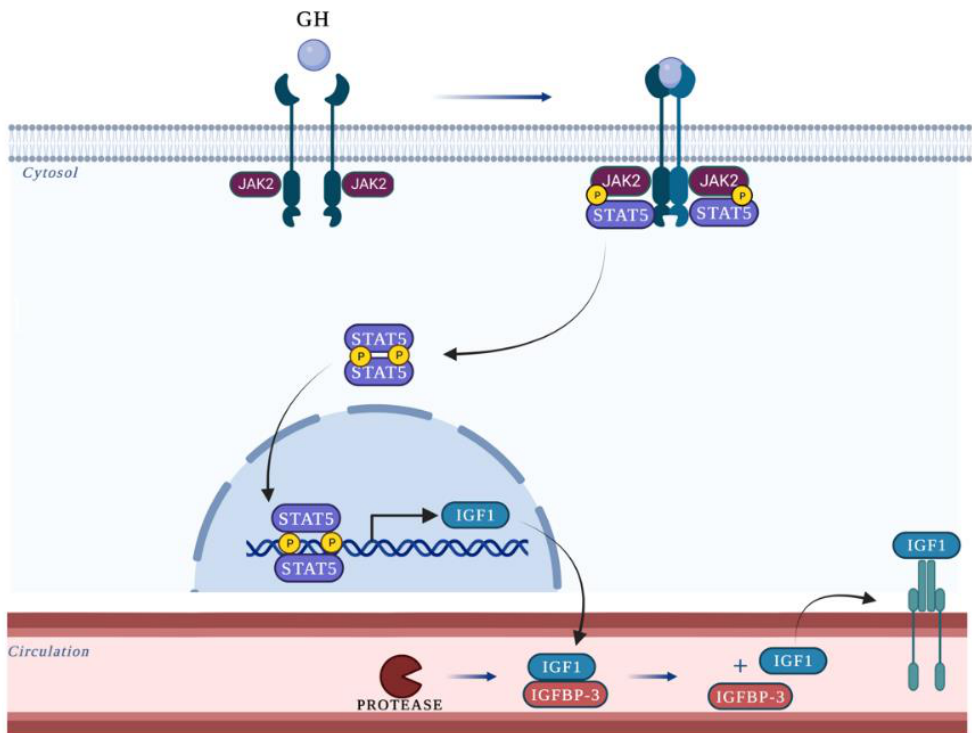
Figure 5. GH leads to dimerization of its receptor (GHR), promoting phosphorylation of Janus kinase (JAK) and consequent activation of STAT proteins. This event results in the dimerization and translocation of STATs to the nucleus. In the nucleus, STAT proteins are capable of binding to the IGF-1 promoter, initiating the transcription of this gene. In circulation, much of IGF-1 is bound by IGF-binding proteins (IGFBPs). Among these, IGFBP-3 is the primary carrier of IGF-1 in plasma, and it acts as a carrier protein and regulator of IGF-1 bioavailability.